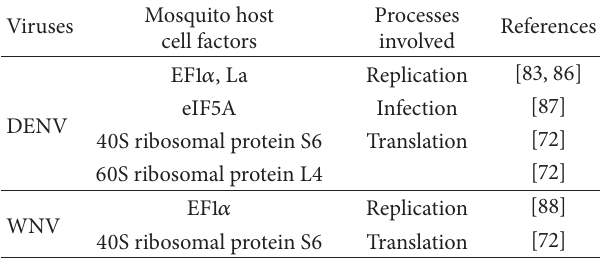
Table 4: Cellular factors involved in the flavivirus transla-